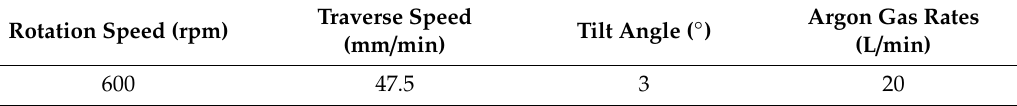
Table 2. Processing parameters of FSP-repaired 34CrNiMo6 alloy.